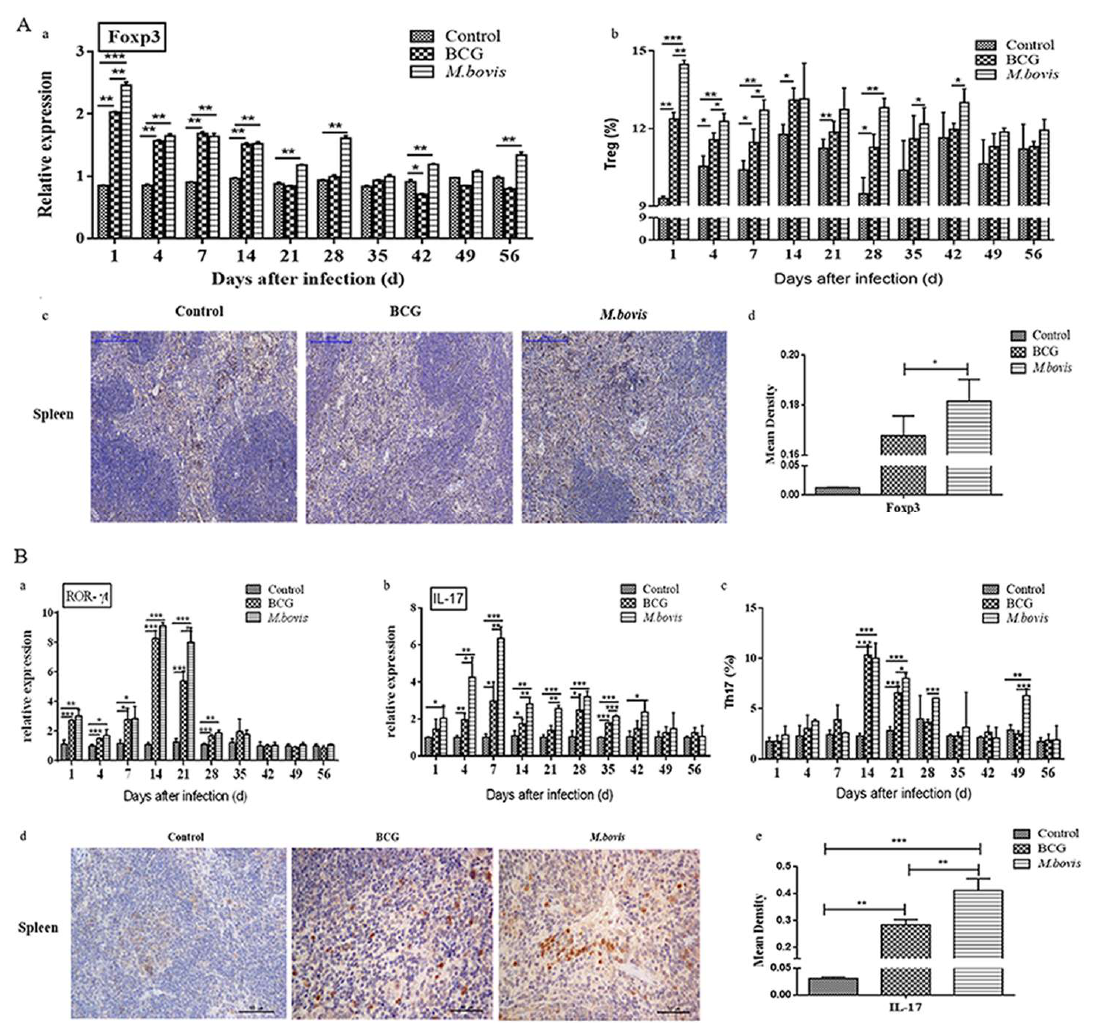
Figure 9. Di ff erentiation of CD4 + Treg and Th17 cell subsets in mice induced by M. bovis and BCG infection. Treg ( A ) and Th17 ( B ) cells in the spleen of M. bovis - and BCG-infected mice. Mice were infected with M. bovis and BCG by tail vein injection with 2 × 10 5 CFU each and sacrificed on 1, 4, 7, 14, 21, 28, 35, 49, and 56 days PI. The total RNA of spleens in different mice groups was collected to detect transcription factors, including Foxp3 ( A-a ), ROR-γt ( B-a ), and IL17 ( B-b ), by qRT-PCR. Splenocytes were gated, and the proportion of Treg (CD25 + Foxp3 + ) ( A-b ) as well as Th17 (CD4 + IL-17A + ) ( B-c ) was analyzed with flow cytometry and then calculated by analyzing FACS data. The expression of Foxp3 ( A-c , 100×) and IL17 ( B-d , 400×) was measured with immunohistochemistry (IHC). Blue indicates cellular nuclei and yellow represents a positive signal of Foxp3 ( A-d ) or IL17 ( B-e ). Cells were quantitatively evaluated by Image-Pro Plus. The data are shown as the mean ± SD of three replicates, where * represents p < 0.05, ** represents p < 0.01, and *** represents p < 0.001.